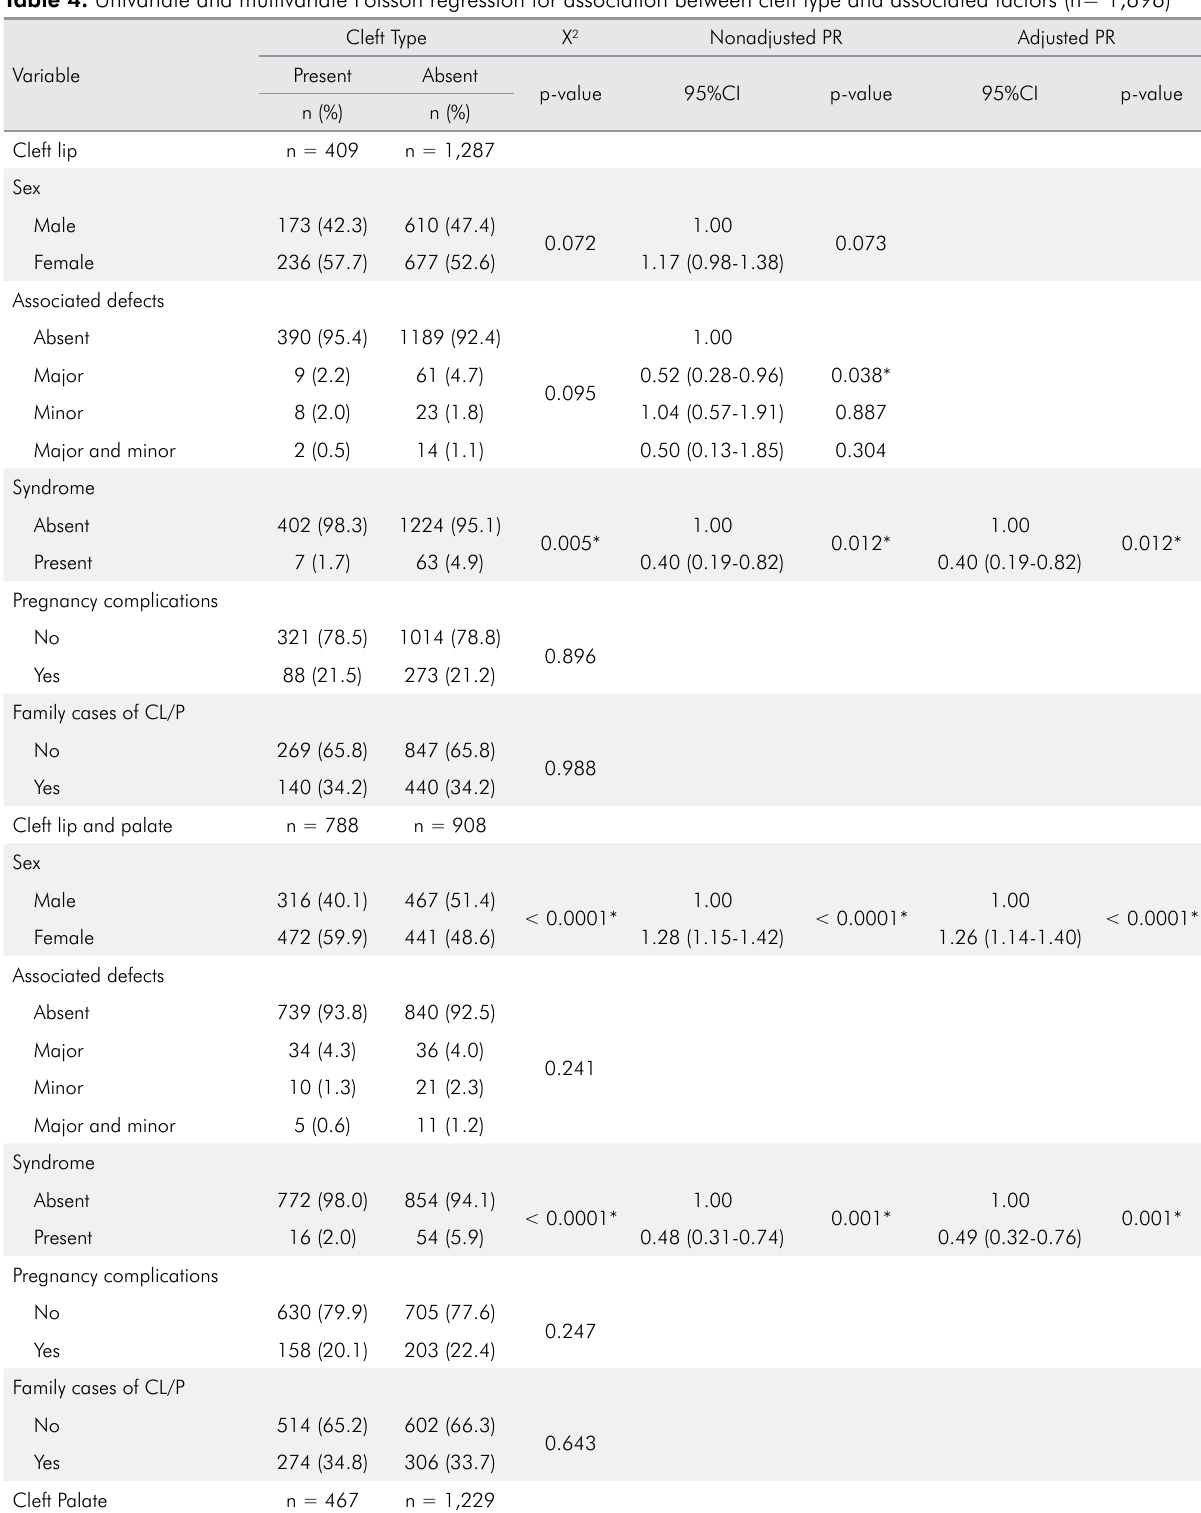
Table 4. Univariate and multivariate Poisson regression for association between cleft type and associated factors (n= 1,696)